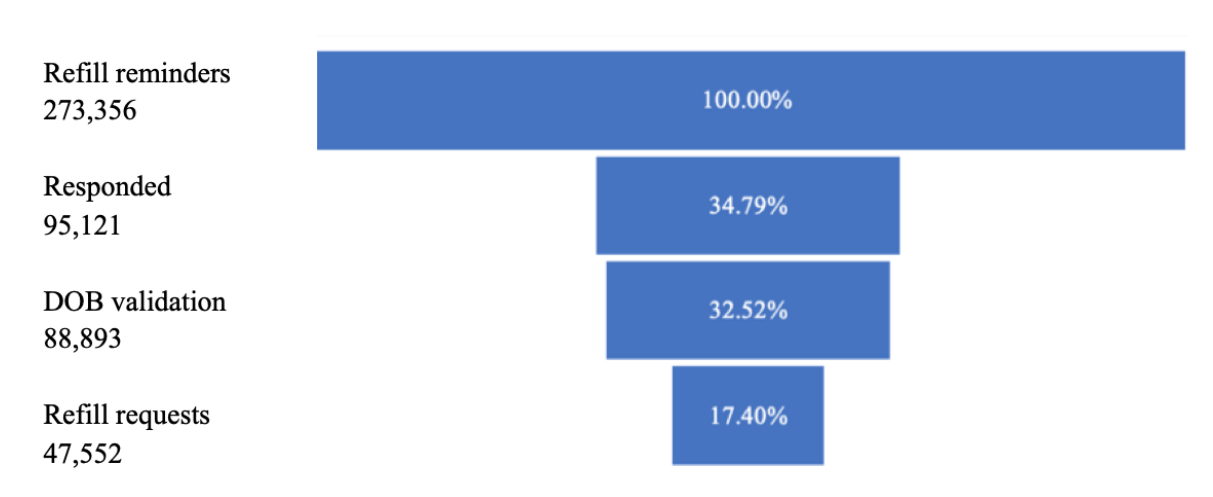
Figure 2. Conversion of refill reminder to refill request. DOB: date of